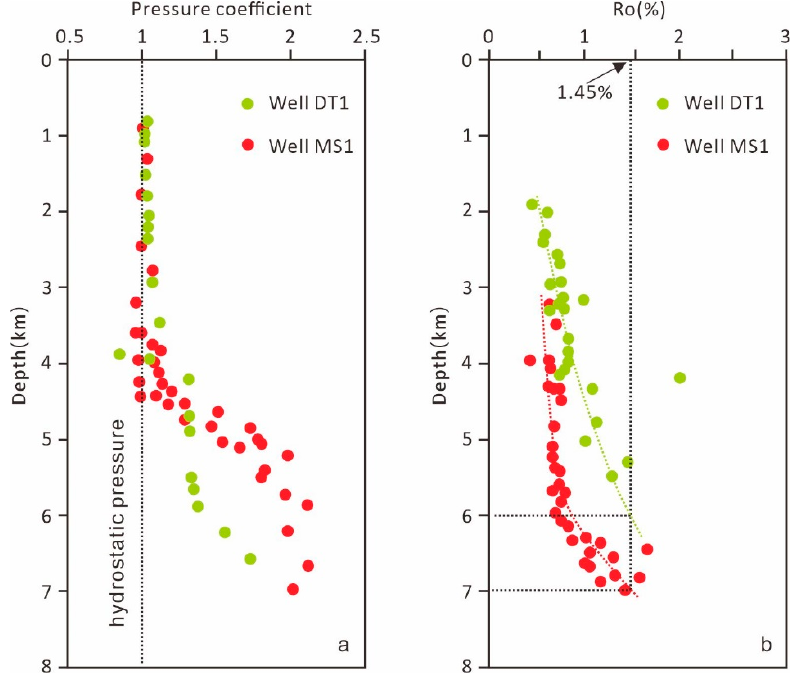
Figure 7. Diagram of the relationship between pressure coefficient, R o and depth of the Junggar Basin. ( a ) relationship between pressure coefficient and depth; ( b ) relationship between R o and depth